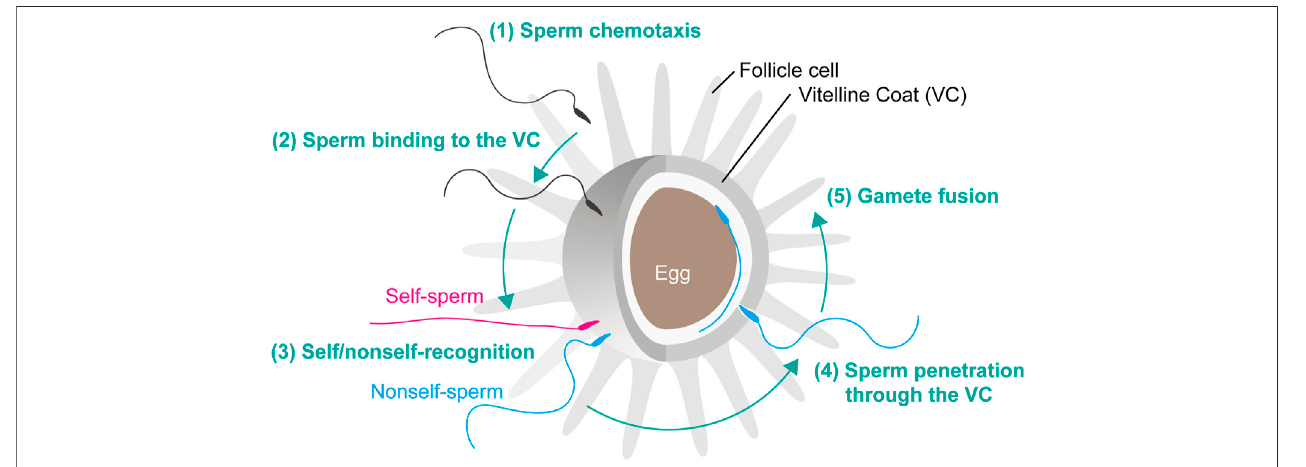
FIGURE 1 | Fertilization steps of C. intestinalis. Fertilization is initiated by the following steps. (1) Sperm chemotaxis. (2) Binding of spermatozoa to the VC. (3) Interaction of self/nonself-recognition proteins that induce the signal transduction cascade leading to the SI response. (4) Penetration of nonself-recognized sperm through the VC. (5) Fusion of the egg and sperm plasma membranes resulting in fertilization and subsequent activation of zygote development.